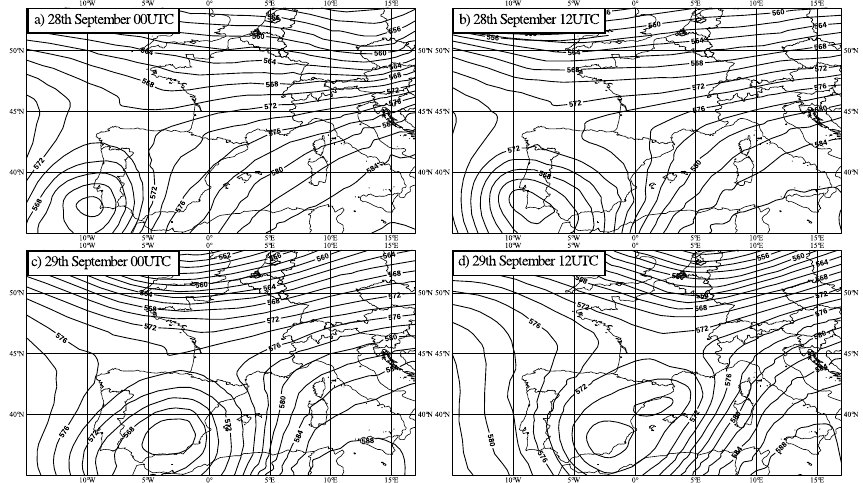
Figure 20. Geopotential height at 500hPa (in dam) from operational ARPEGE analyses.